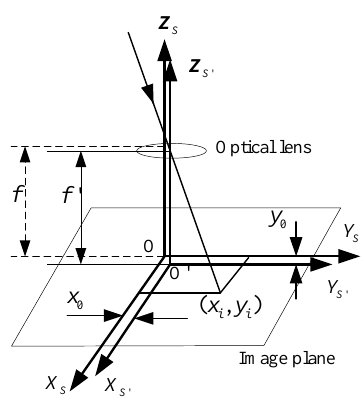
Figure 1. Traditional model of star sensor error.